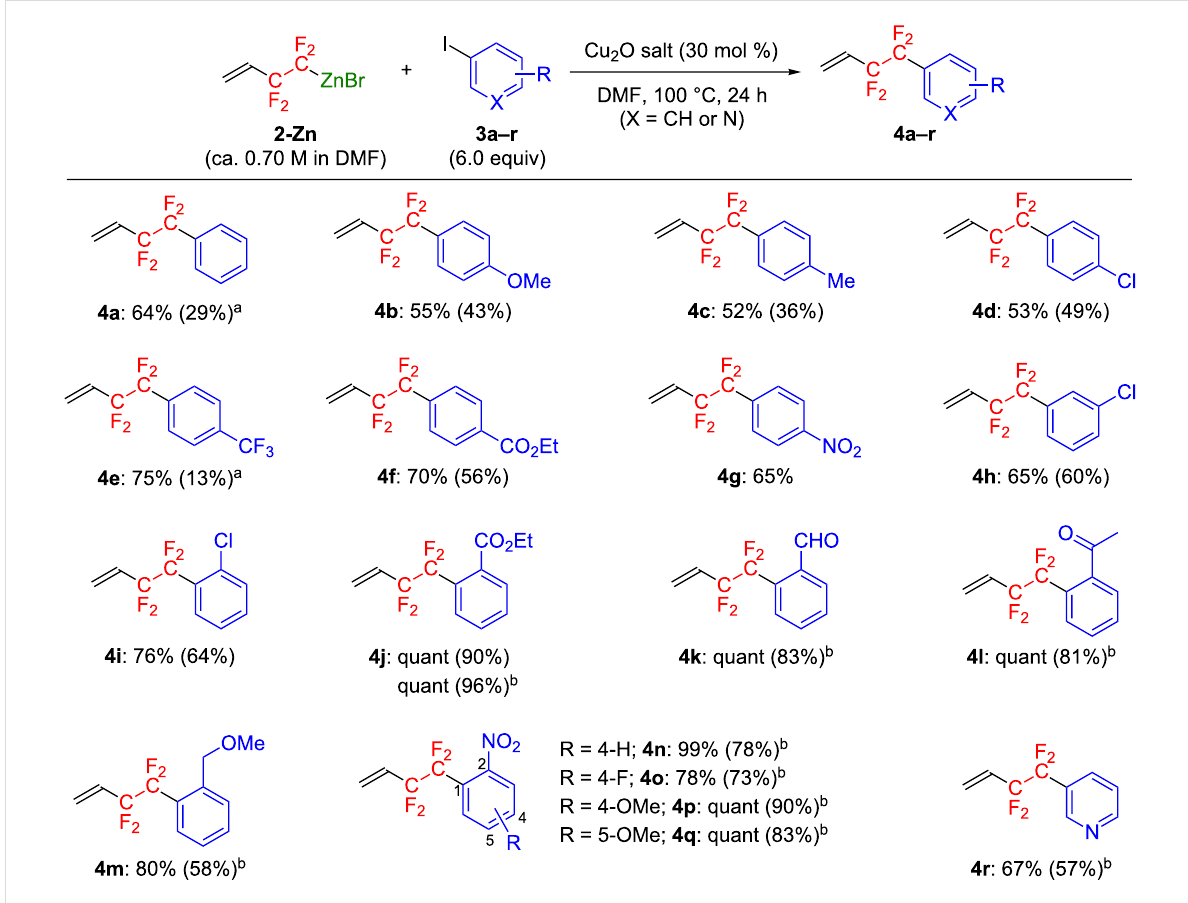
Figure 3: Copper(I)-catalyzed cross-coupling reaction of 2-Zn with various iodoarene derivatives. NMR (isolated) yields are indicated. a Low yields are due to the low boiling point and/or the high volatility of the products. b Reaction was carried out using 1.0 equiv of 3 and 2.0 equiv of 2-Zn in the pres- ence of 60 mol % of Cu 2